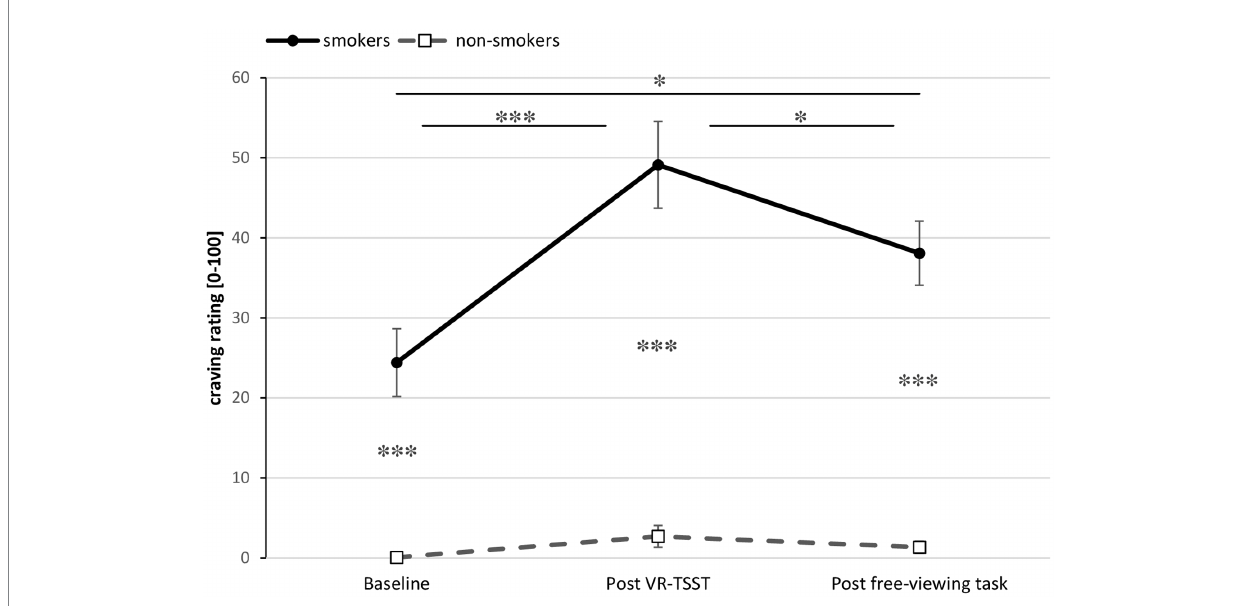
FIGURE 4 Craving ratings during the course of the experiment for smokers ( n = 34) and non-smokers ( n = 37). Ratings at baseline and post VR-TSST were given retrospectively. Asterisks indicate significant differences. Error bars show standard errors.